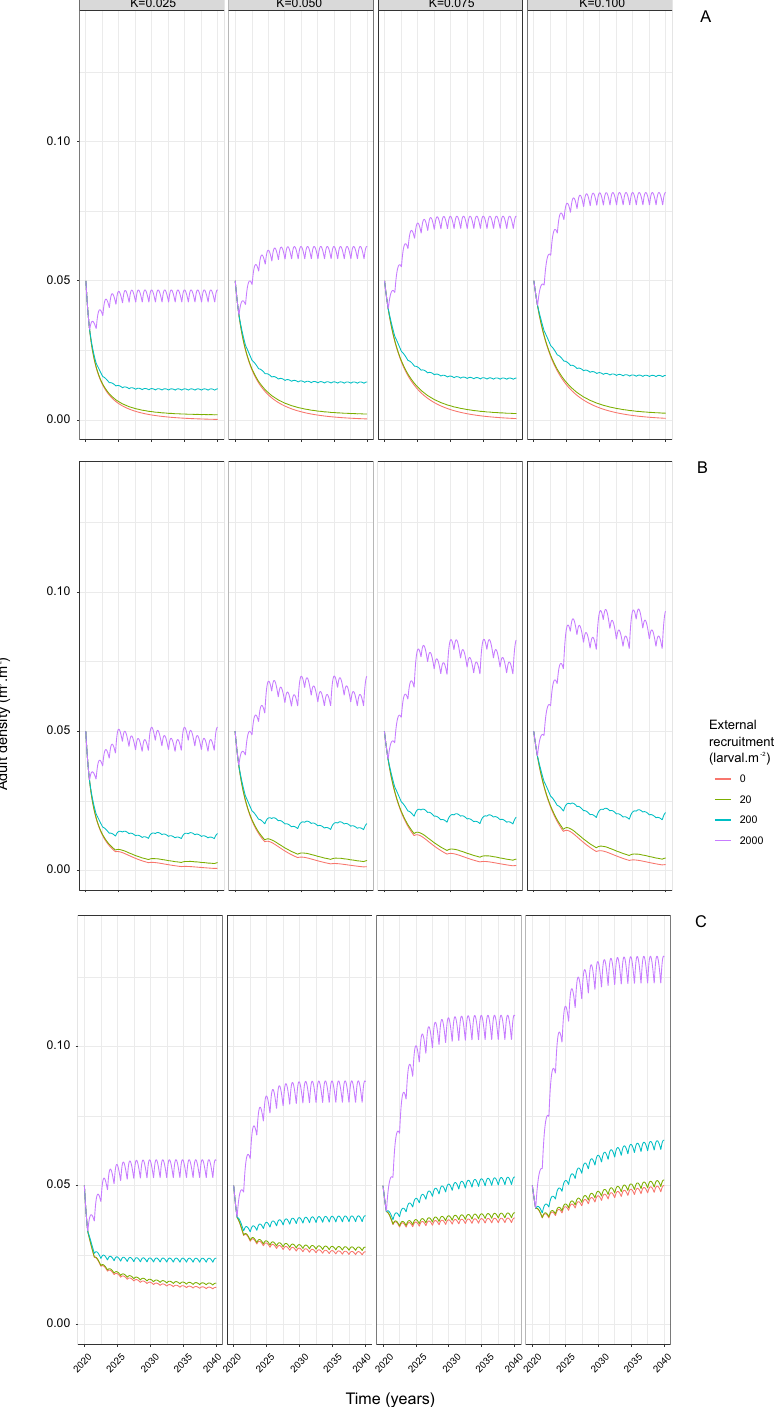
3 m − 2 Figure 2. Adult density of the wild population ( m ) over time with ( A ) no spawning event, ( B ) spawning events every 5 years, and ( C ) annual spawning events, for 4 levels of external recruitment (orange—R = 0 larvae m − 2 , green—R = 20 larvae m − 2 , blue—R = 200 larvae m − 2 , purple—R = 2000 larvae m − 2 ) and 4 carrying capacities (from the left to the right, K = { 0.025 ; 0.05 ; 0.075 ; 0.1 } . The wild population is assumed to be initially 3 m − 2 established at a density A 0 = 0.05m